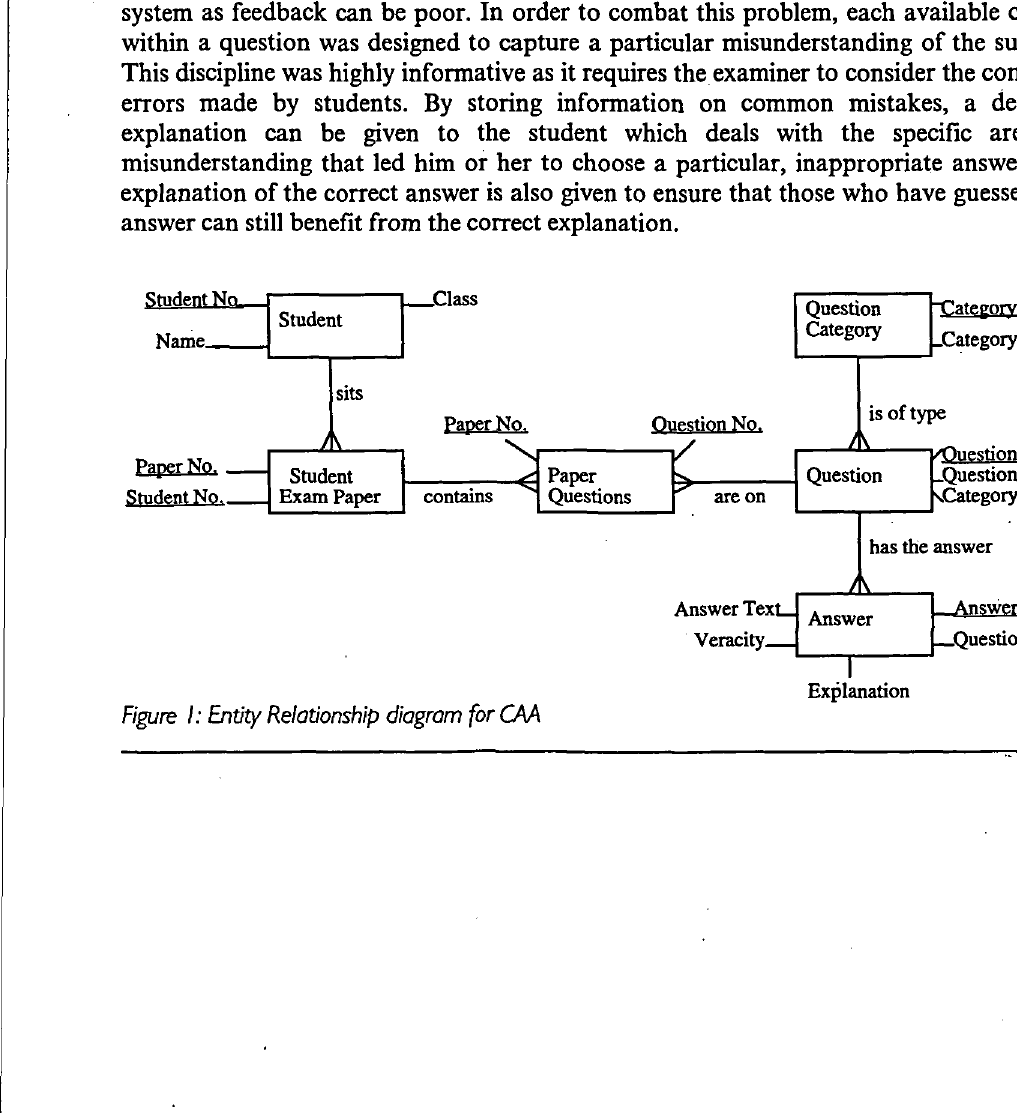
Figure /: Entity Relationship diagram for